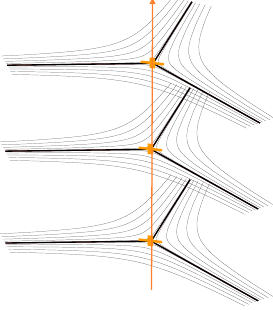
Figure 13 . The local structure of the WKB foliation of M = C (cid:2) R for N = 2 around the branch locus. We explicitly show leaves at three discrete positions in the x 3